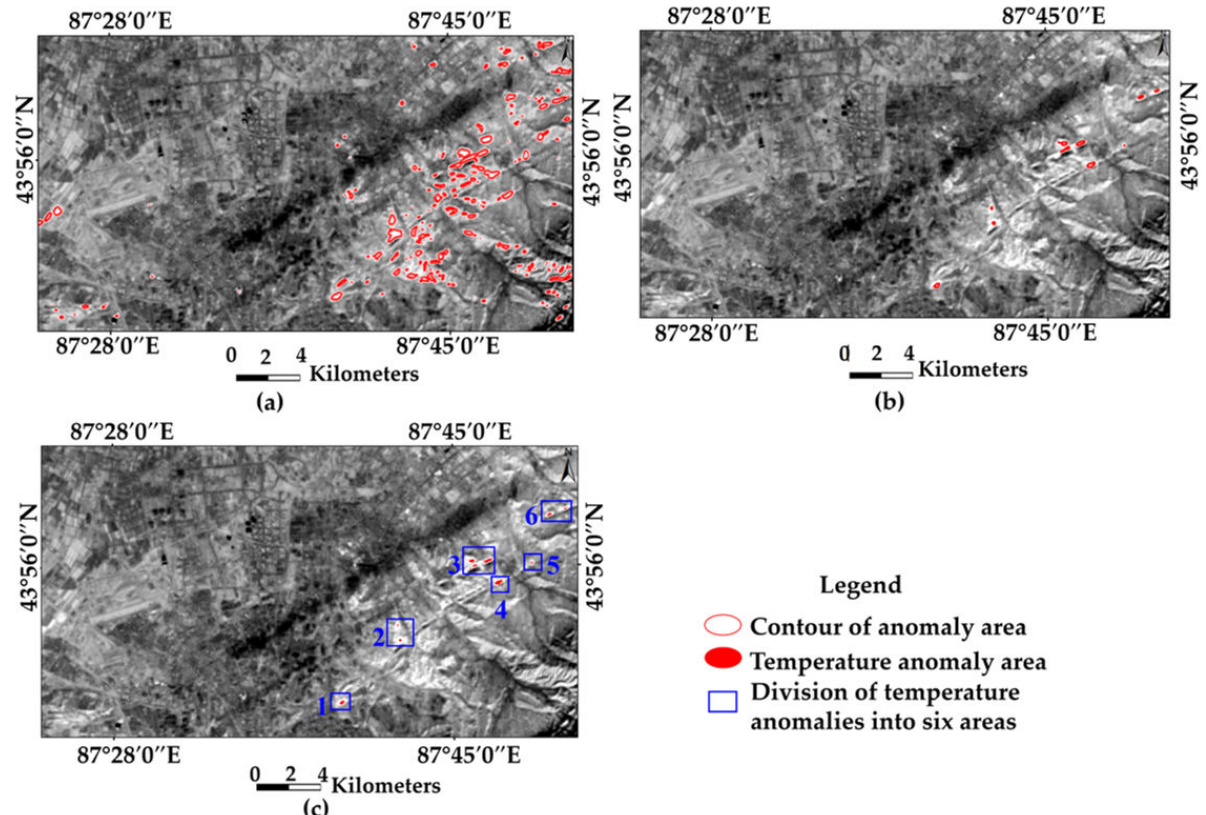
Figure 5. Process of detecting temperature anomalies using satellite data: ( a ) 20 iterations, ( b ) 152 iterations, and ( c ) final temperature anomaly